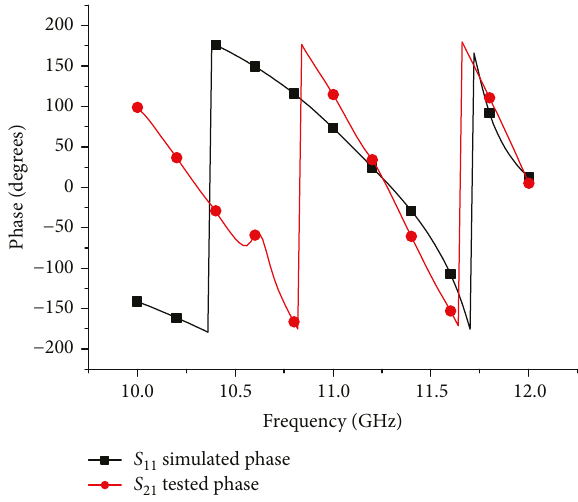
Figure 10: Simulated and tested scattering parameter